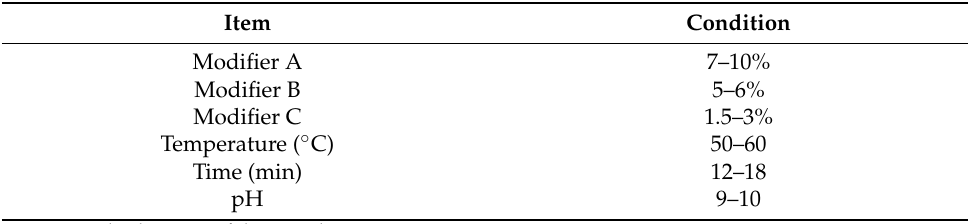
Table 1. Process conditions of surface neutralizing (Modifier A/B/C were purchased from MacDer- mid Co., Shanghai, China).